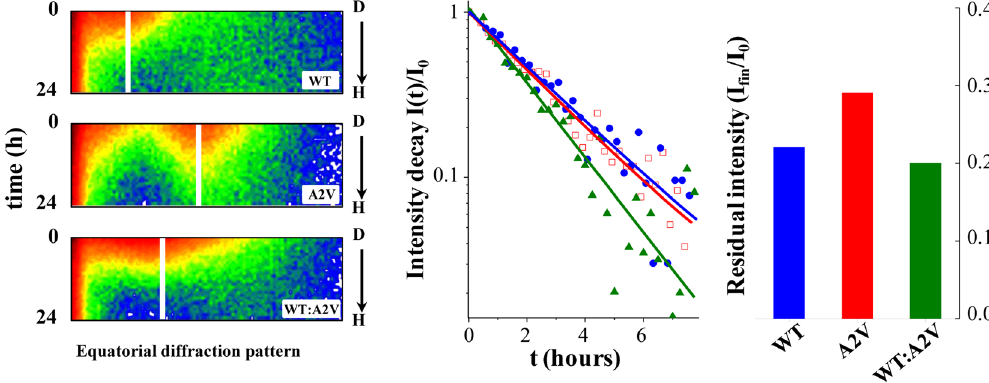
Figure 3. Analysis of neutron scattering changes due to H-D exchange in WT, A2V, and WT:A2V samples. ( Left ) Time-dependent change (D-H) in neutron scattering upon replacement of D 2 O with H 2 O in the tubular reservoir of the sample holder. ( Middle ) The decay in intensity of the predominant neutron scattering peak, I(t)/I o , during about eight hours, was fit by an exponential. The exchange times for WT, A2V, and WT:A2V, were 2.58 h, 1.90 h, and 2.45 h, respectively. ( Right ) Histogram showing the residual intensity of the major peak, calculated from the asymptote of the plateauing intensity after D 2 O → H 2 O